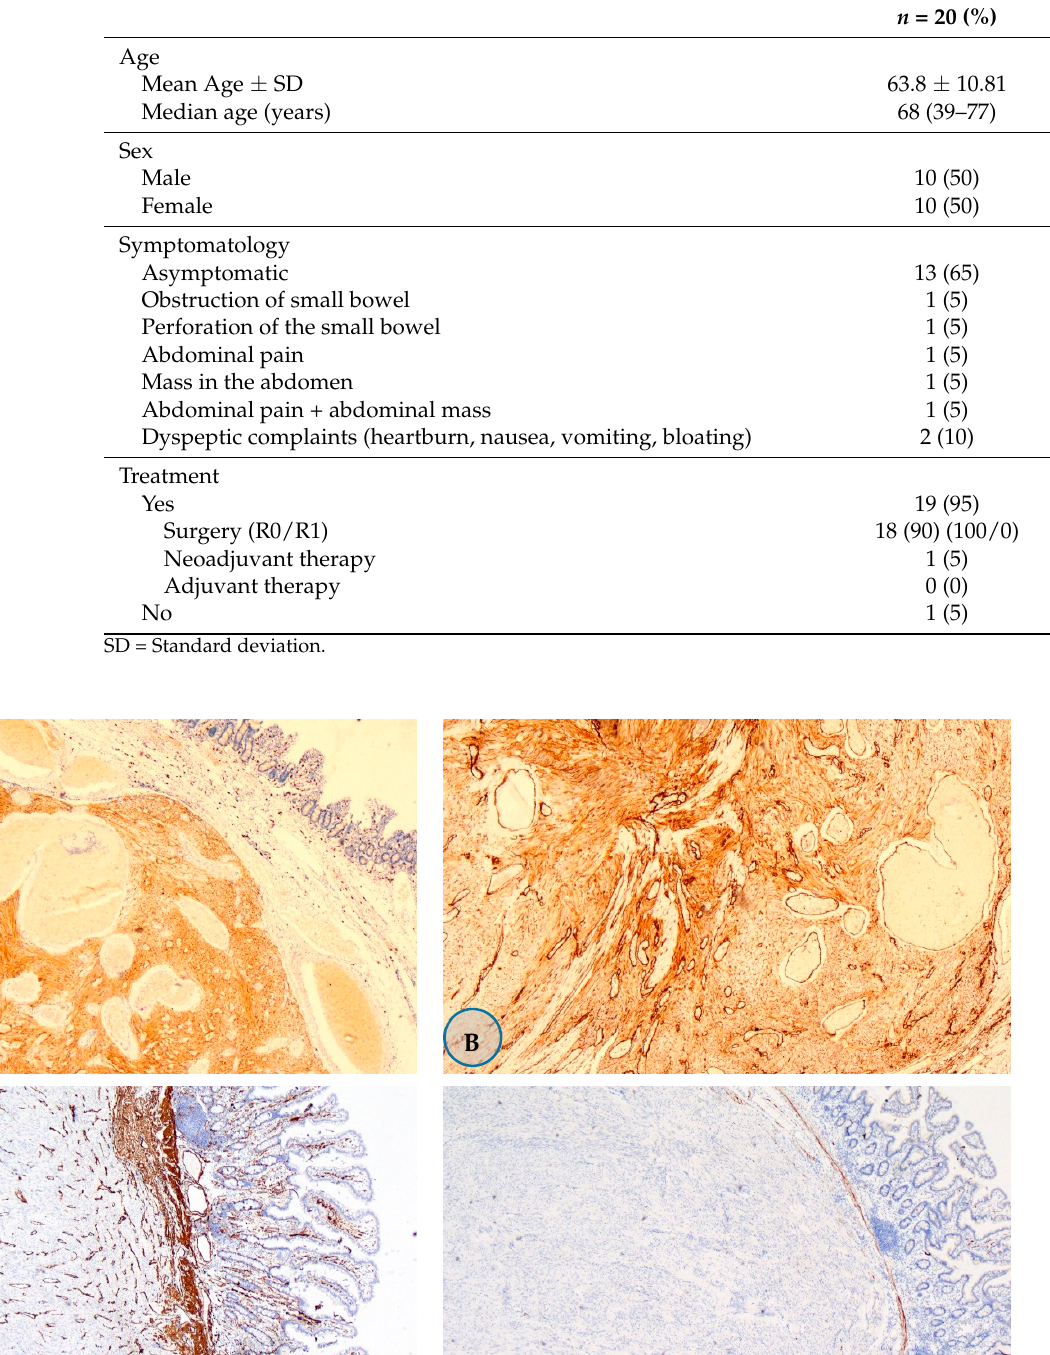
Table 1. Characteristics of patients with gastrointestinal stromal tumor.